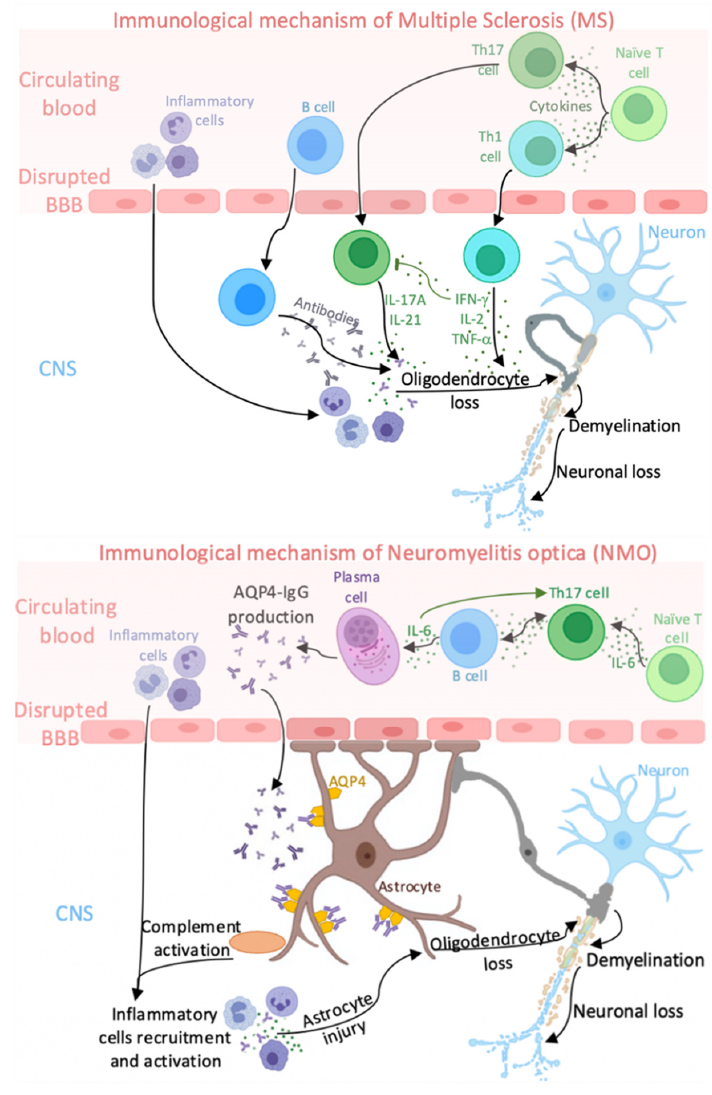
Figure 1. Immunological mechanism of MS and NMO. In MS: T helper (Th)-17 and Th1 cells differentiate from naïve T cells. The differentiation is stimulated by interleukin (IL)-1, IL-6, IL-12, IL-18, and IL-23. Th17 and Th1 cells alongside B cells infiltrate the central nervous system (CNS) at areas of increased blood–brain barrier (BBB) permeability. Herein, Th1 and Th17-related cells produce mainly pro-inflammatory cytokines which induce inflammatory cells infiltration. Immunopathogenesis driven by Th1 cells is strictly associated with Th17 cells, which are susceptible to the inhibition by IFN- γ . Moreover, B cells produce antibodies reactive against myelin antigens. Subsequently, inflammatory cells alongside cytokines and antibodies lead to oligodendrocyte loss, demyelination, and finally, neuronal loss. In NMO: Th17 cells differentiate from naïve T cells. The differentiation is stimulated by transforming growth factor (TGF)- β , IL-1 β , IL-6, IL-7, IL-21, and IL-23. Th17 cells, inducing pro-inflammatory cytokines, including IL-6, interact with B cells, which stimulate plasma cells to produce aquaporin (AQP4)-4-IgGs. Besides, increased level of IL-6 associates with the tendency to release more IL-17A by Th17 cells and the proper differentiation of Th17 cells depends on IL-6 and IL-21 high level. AQP4-IgGs infiltrate into the CNS at areas of increased BBB permeability and then bind selectively to AQP4 on astrocytic endfeet. This binding induces the complement activation, which leads to the recruitment of peripheral inflammatory cells. Subsequently, inflammatory cell recruitment and activation alongside cytokines cause astrocyte injury, oligodendrocyte loss, demyelination, and finally, neuronal loss.